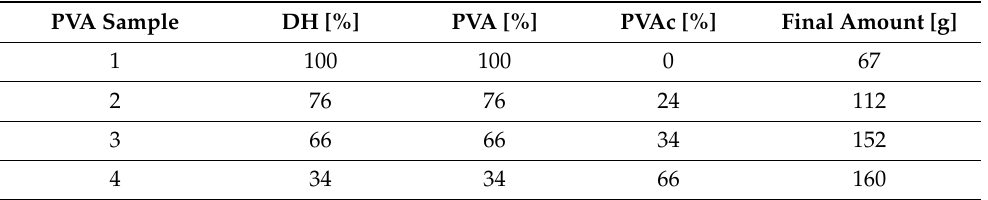
Table 2. Degree of hydrolysis of PVA for PVA samples